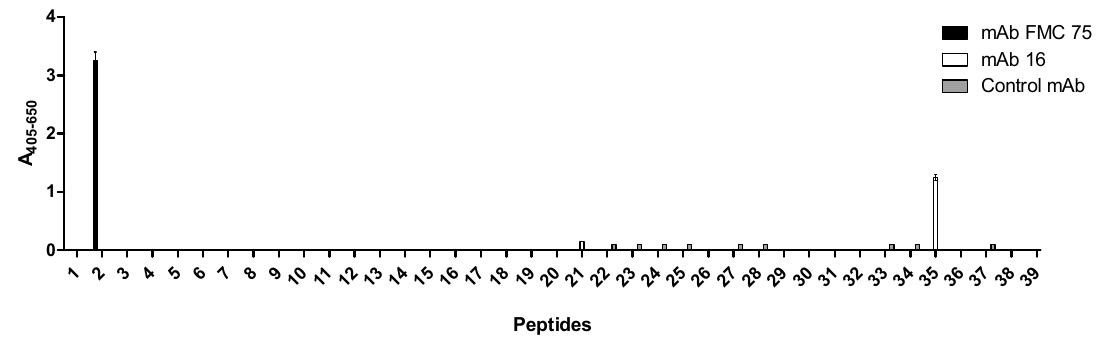
Figure 2. Antibody reactivity to overlapping calreticulin peptides analyzed by modified enzyme-linked immunosorbent assay using resin-bound peptides. Mouse anti- β -galactosidase was used as a negative control. Based on the current findings, peptide 2 (LDGDGWTSRWIESKHKSDFG) and 35 (KDKQDEEQRLKEEEEDKKRK) were selected for epitope identification.